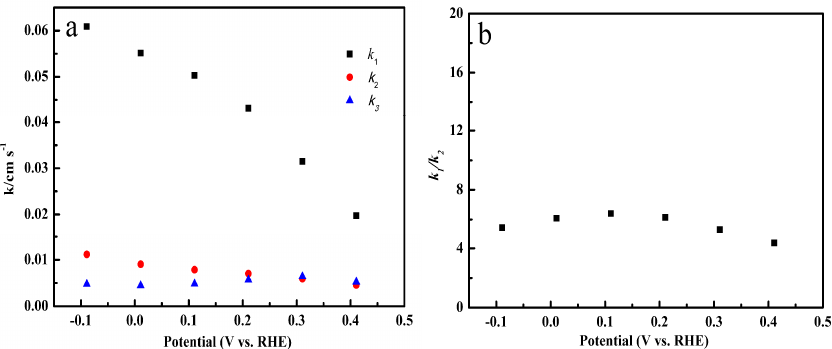
Figure 10. Values of k 1 , k 2 , and k 3 of the ORR pathway model for Cu ‐ SOCBP/C ( a ); and the ratios of k 1 / k 2 ( b